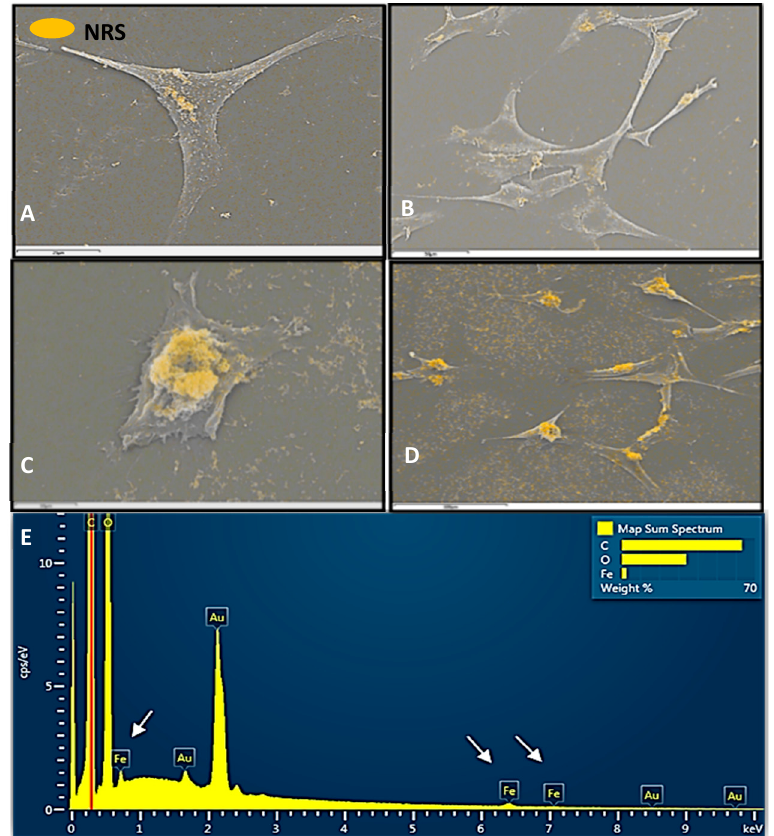
Figure 13. SEM images show the uptake and localisation of BPEI ‐ coated IONRs in U87 cells at different concentrations after 24 h of incubation: ( A , B ) a 5 μ g/mL concentration shows the uptake of BPEI ‐ coated IONRs without affecting the live cells; ( C , D ) a concentration of 10 μ g/mL BPEI ‐ coated IONRs shows the overloaded uptake of BPEI ‐ coated IONRs, which affects the nucleus. ( E ) The localisation around the nuclei was detected by the EDS map scan spectrum. Areas with iron localisation are distinguished by pseudo ‐ colour that was applied simultaneously to the images to highlight IONRs as yellow. Scale bars are 25 μ m ( A , C ) and 50 μ m ( B , D ).